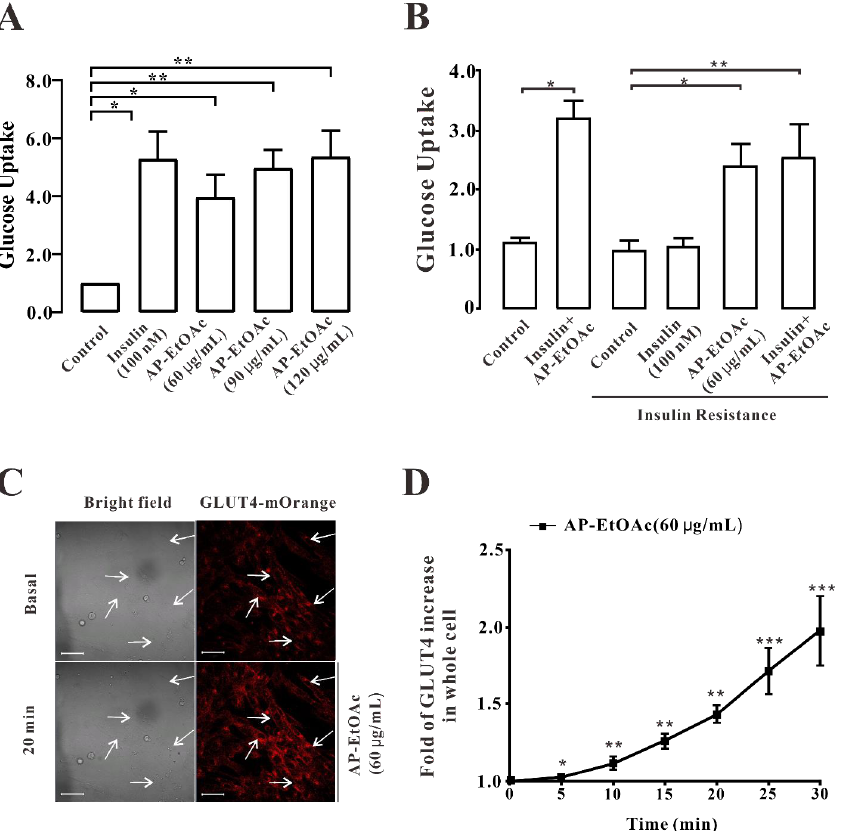
Figure 2. AP-EtOAc promoted the uptake of glucose and enhanced GLUT4 transport in L6 cells. ( A ) Values on the Y-axis represent the fold relationship of glucose uptake by L6 cells compared with that in normal conditions. Uptake of glucose detected using a Glucose oxidase kit in L6 cells, the data represent the mean ± s.e.m. of values from three separate experiments. The control group was considered as 1 for data analysis. ( B ) Values on the Y-axis represent the fold relationship of glucose uptake by L6 cells compared with that in normal conditions. Uptake of glucose in L6 cells induced by AP-EtOAc in insulin resistant L6 cells, the data represent the mean ± s.e.m. of values from three separate experiments. ( C ) Images of 60 μg/mL AP -EtOAc stimulating GLUT4 transport in L6 cells. Scale bar = 50 μm. ( D ) Calculation of fluorescence intensity in myc-GLUT4-mOrange-L6 cells using Zen 2010 software, n = 30 cells. *: p < 0.05; **: p < 0.01, ***: p < 0.001.